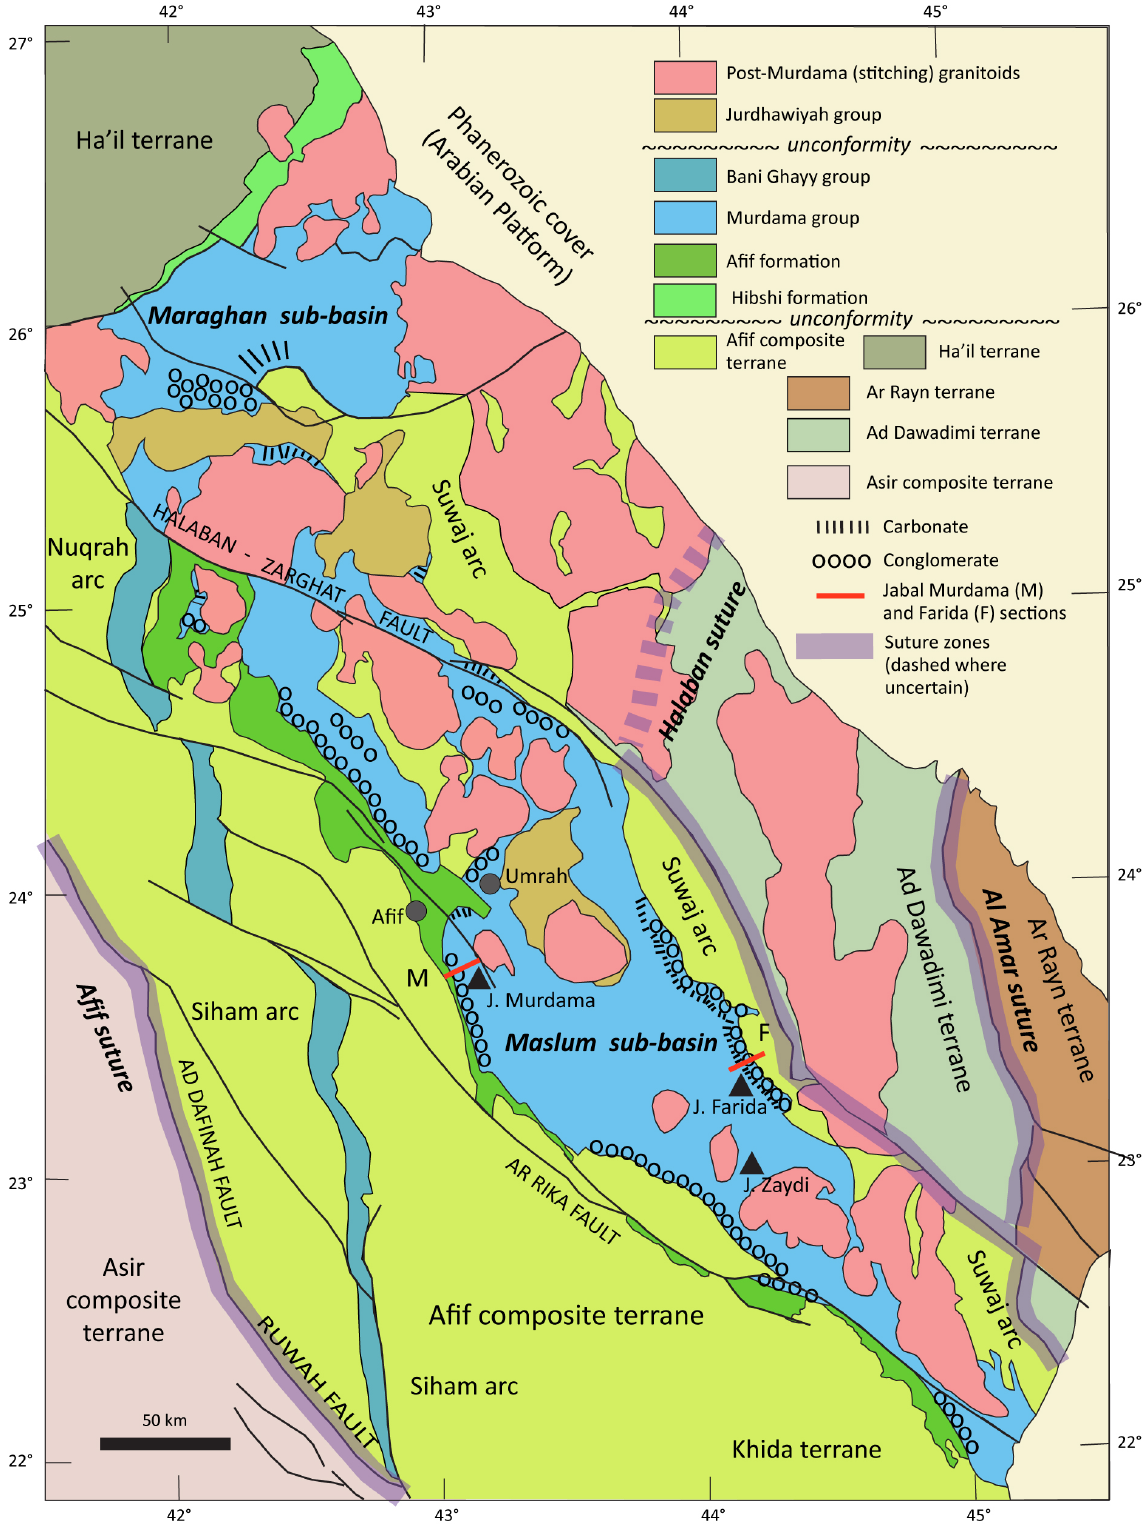
Figure 11. Simplified map of post-amalgamation basins in the northeastern Arabian Shield (after [9]). The largest basin, filled by the Murdama group, is located toward the eastern margin of the Afif composite terrane overlying the Khida subterrane, and Nuqrah, Siham, and Suwaj arcs. The Jurdhawiyah group occupies basins unconformable on the Murdama